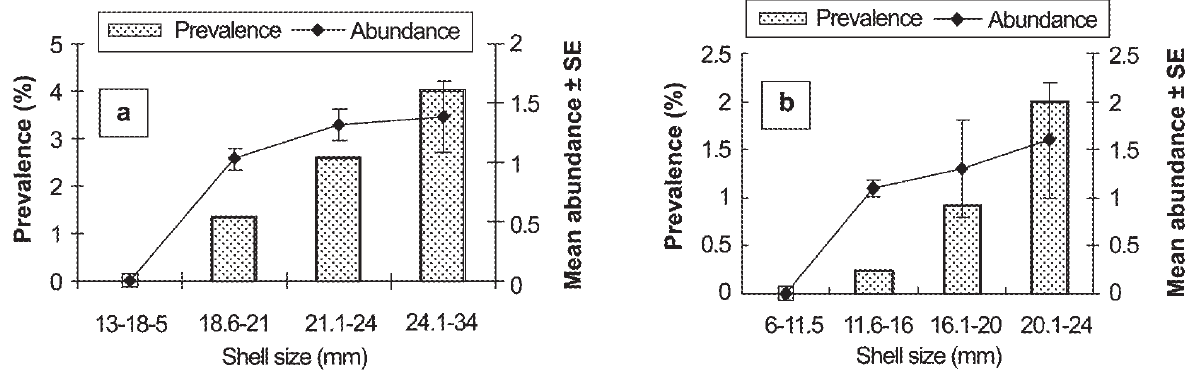
61-70Fig. 3. – Infection prevalence and mean abundance (± SE) of P. cantonensis in relation to shell size (mm) in L. carinatus (a) and M. tuber- culata (b).